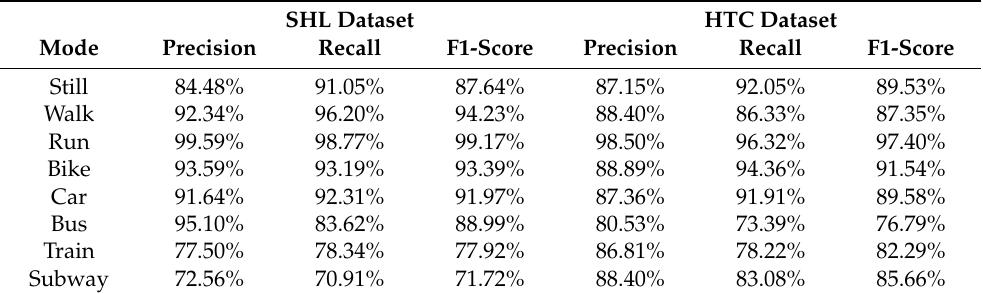
Table 7. Experimental results of removing the multi-headed attention